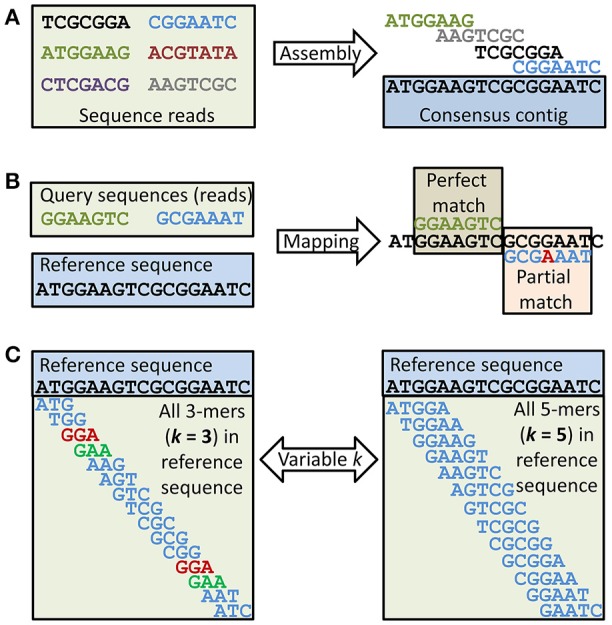
Metagenomics data analysis. At least three different approaches for analysis of HTS sequence reads can be selected, but combinations are often preferred. (A) Assembly of sequences (e.g., reads) into contigs (consensus sequences) requires mapping. Sets of contigs are often further assembled into scaffolds (not shown), where the relative position of contigs is known but gaps of ± known size between the contigs remain to be closed. The example shows that four of the six reads can be assembled into a consensus contig while the two remaining reads cannot be assembled with any of the others. (B) Mapping of sequences (e.g., reads) to other sequences (e.g., in database) also requires mapping. The example shows one perfect and one partial match between two query sequences (e.g., reads) and a reference sequence. The mismatch in the partial match is shown in red. (C) Any sequence larger than one nucleotide can be divided into subsequences of length k ≥ 1. The size of k will affect the likelihood of any random k-mer being unique to a data set. A small k will reduce the number of unique k-mers. This is demonstrated in the example, as for the given reference sequence two k-mers will not be unique with k = 3, while with k = 5 all k-mers are unique. Rare k-mers or k-mer frequencies can be used to estimate relationships between two sets of sequences (e.g., two shotgun metagenomes or a sequence isolate and a reference genome).